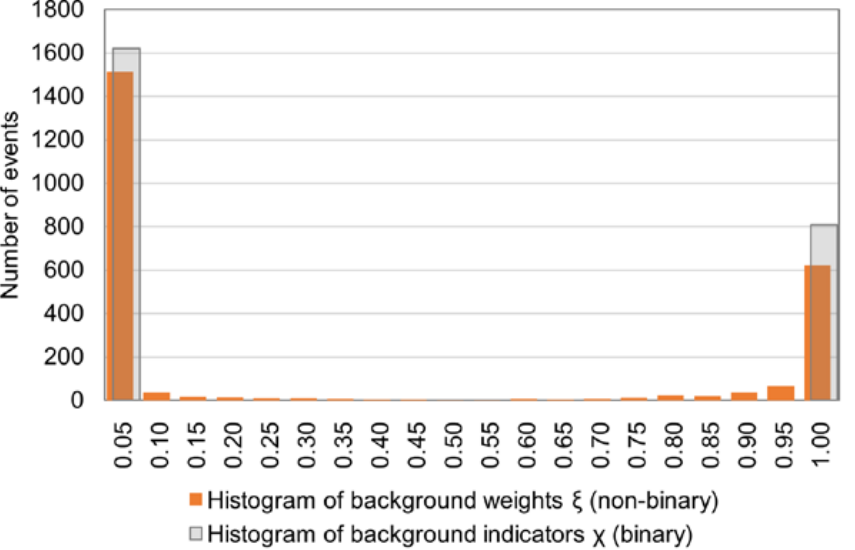
plotted at 10 km pixel size (unit is 𝜇𝜇 ∙ 𝑢𝑢 ( 𝑥𝑥 , 𝑦𝑦 )